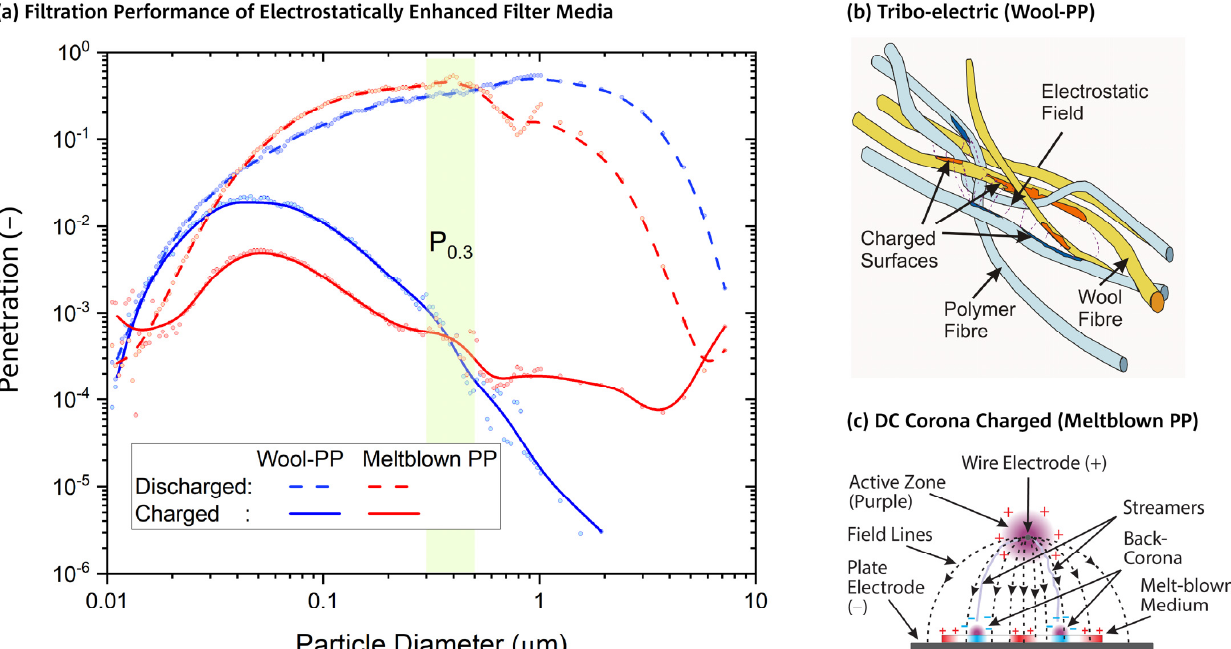
Figure 1. ( a ) An example of the particle-size dependence of penetration for charged and discharged wool/polypropylene (Wool–PP, WP) and melt blown polypropylene (Meltblown PP, MBP; Shanghai Da Sheng [5]) mask media when tested at a face velocity of 0.15 m/s. Pressure drop, thickness, fabric areal density, maximum penetration, and most penetrable particle size (MPPS) of MBP: 200 Pa, 3.0 mm, 280 g/m 2 , 0.5%, 48 nm; WP: 50 Pa, 8.8 mm, 600 g/m 2 , 2.2%, and 46 nm, respectively. The particle diameter size range used for measuring penetration P 0.3 has been highlighted in green. Trendlines (B-Spline) have been added for illustration purposes to measurements represented by dots. ( b ) Fiber-polymer specific charge distribution in electrostatically enhanced media of the tribo-electric type. ( c ) Charge distribution resulting from DC corona charging using a unipolar electrode configuration (example for unipolar, positive electrode configuration [8]).